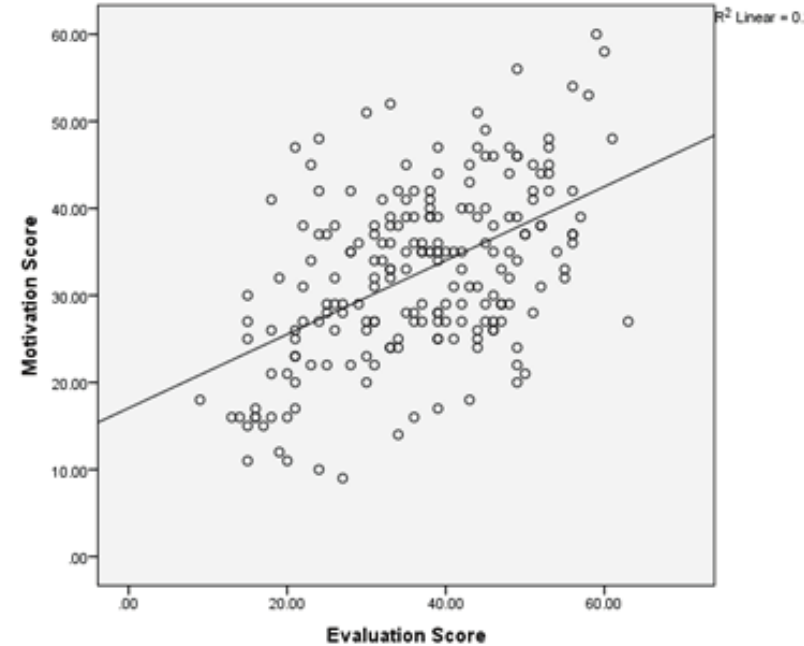
Figure 3: Scatter plot showing the effect of Evaluation score (independent variable) on Motivational score (dependent variable), R2 =